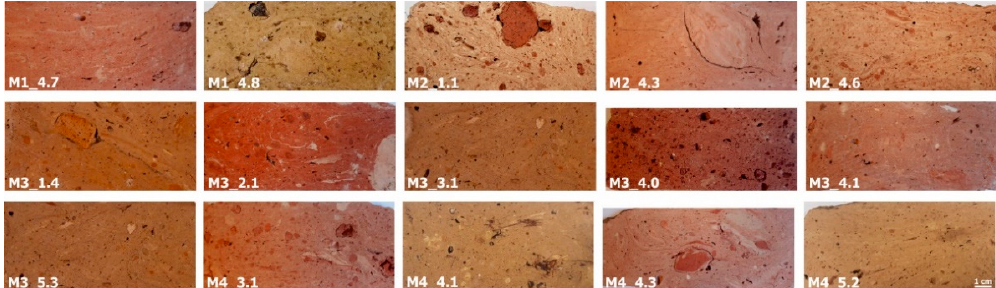
Figure 3. Appearance of the bricks on fresh surface. Very diverse textures and three main colors—yellow/beige, pale and dark red- were observed.